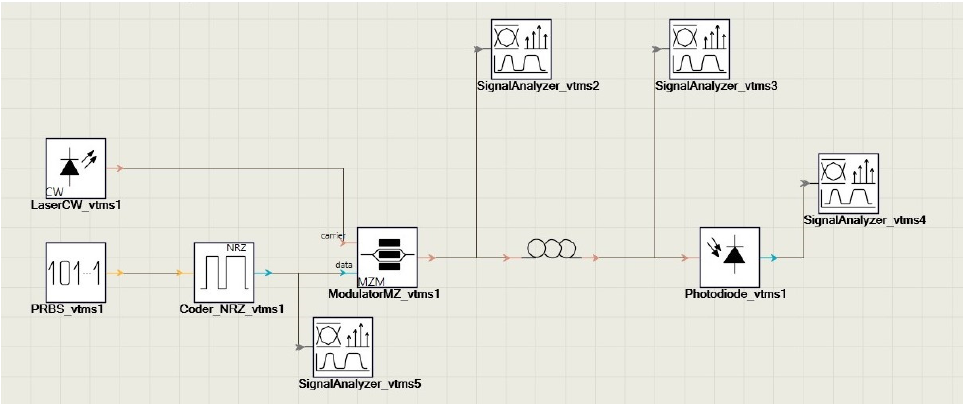
Figure 3. The layout diagram corresponding to the electro-optic arrangement in the VPI photonics software.